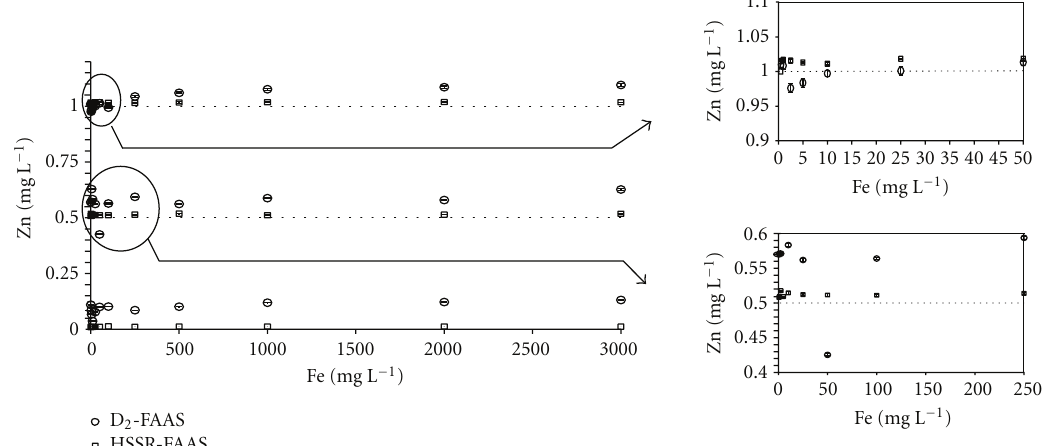
Figure 5: Influence of Fe on the three concentrations of Zn (0.01, 0.5, and 1 mgL − 1 ) measured in 0.5 M hydroxylamine hydrochloride by FAAS at 213.856 nm with the D 2 and HSSR